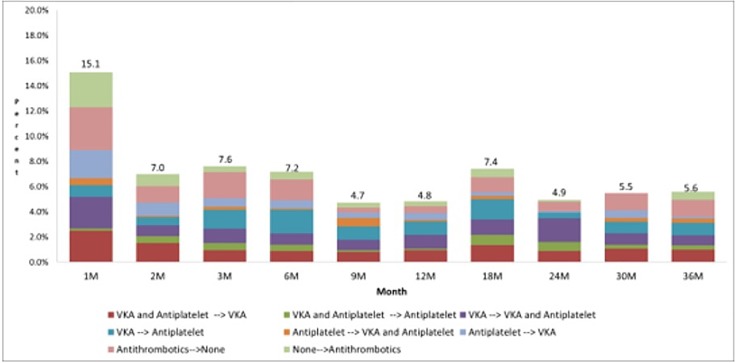
Change of antithrombotic medication at each time point.M indicate month(s); VKA vitamin K antagonists.